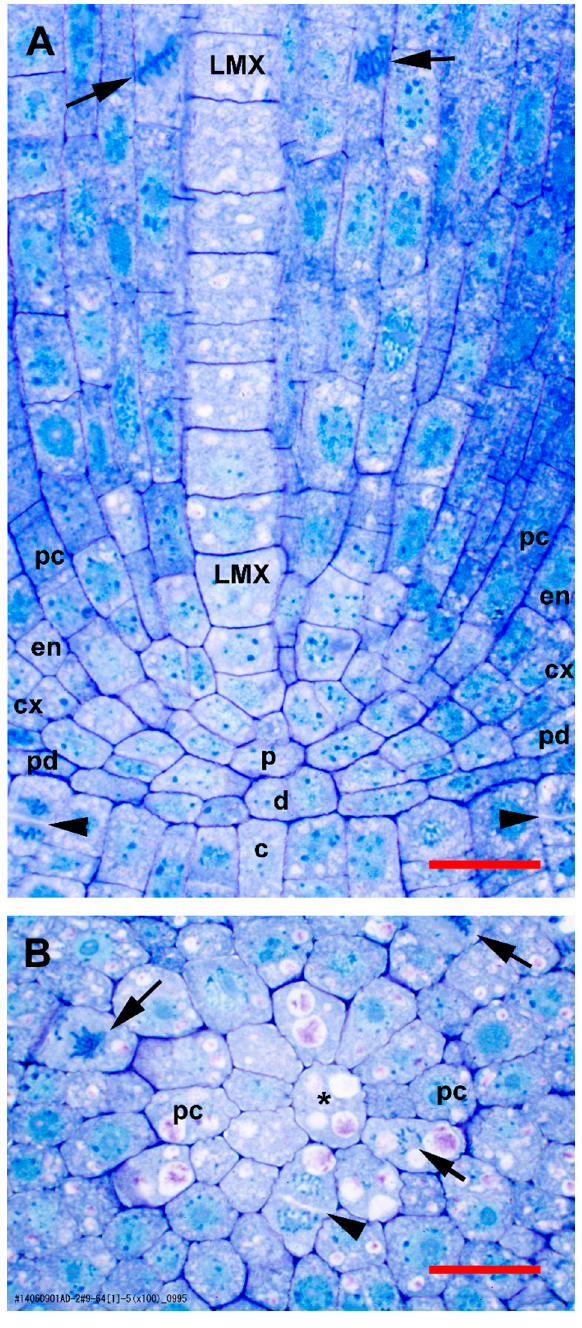
Figure 1. Normal organization of tissues in the promeristem and primary meristem zones of teosinte roots at high magnification. ( A ) Slightly o ff -median longitudinal section. ( B ) Transverse section through the plerome showing a margin initial during cytokinesis (arrowhead) and another in mitosis (arrow). Late-maturing metaxylem (LMX) vessel; asterisk (*), plerome central cell; arrow, mitotic cell; arrowhead, newly forming cell plate; c. calyptrogen; d. dermatogen / periblem complex; p, plerome; cx, cortex; en, endodermis; pc, pericycle; pd, protoderm; rc, rootcap. Scale bar = 25 µ m. Modified from Saito et al. 2019 [6], cf. Figure